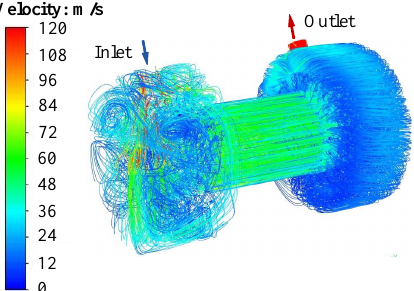
Figure 8. Steamline for the internal fluid field of the prototype.